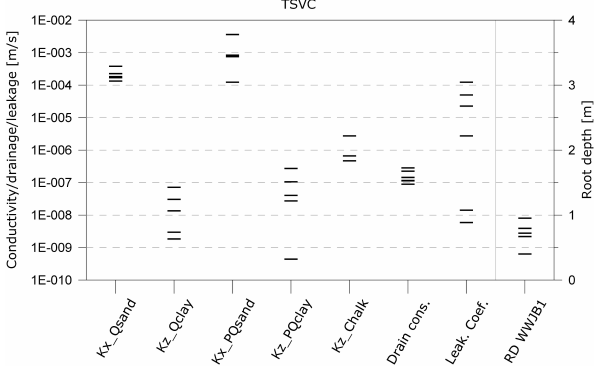
Fig. 7. Optimised parameter values for all model-domains with TSV precipitation correction.